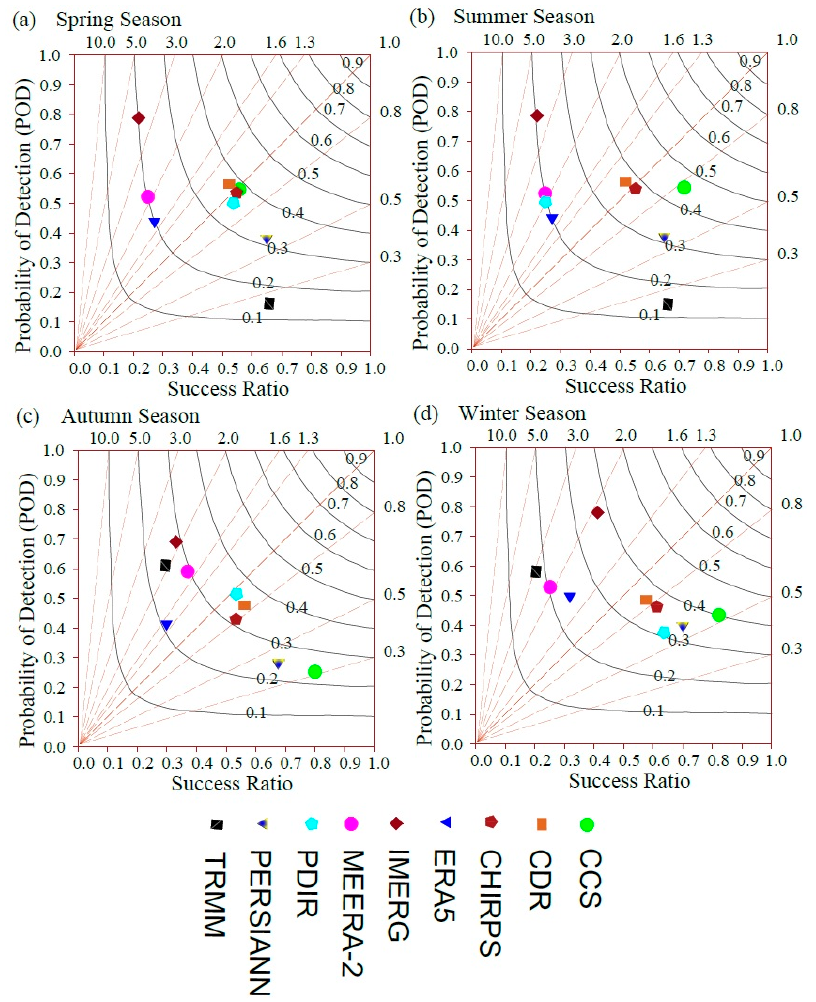
Figure 17. The capability of all reanalysis and SPPs (CCS, CDR, CHIRPS, ERA5, IMERG, MEERA2, PDIR, PERSIANN, and TRMM) to accurately detect the seasonal precipitation. The probability density function (PDF) of the observed daily precipitation rec- ords (obtained from the gauging stations) nine precipitation products (IMERG, TRMM, CCS, CDR, CHIRPS, ERA5, MEERA2, PDIR, and PERSIANN) is shown in Figure 18. The light precipitation events (<2 mm/day) events were most frequent (ap- proximately 72% of all events) over the entire study duration, as indicated by the da- tasets of all sources. MERRA2 products showed a significant underestimation of pre- cipitation at all thresholds. ERA5 indicated the overestimation of light precipitation events but underestimated the moderate and heavy precipitation events. CCS showed a considerable overestimation of moderate events. Generally, IMERG and TRMM products revealed a better performance in tracking the precipitation events at different thresholds. In winter, the PDIR product showed a significant overestimation of slight pre- cipitation events. Conversely, MEERA2 indicated a significant underestimation of